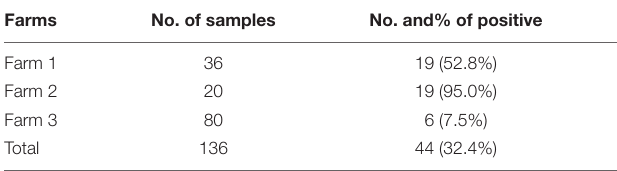
TABLE 1 | Detection rate of ORFV from the peripheral blood of dairy goats. Farms No. of samples No. and% of positive